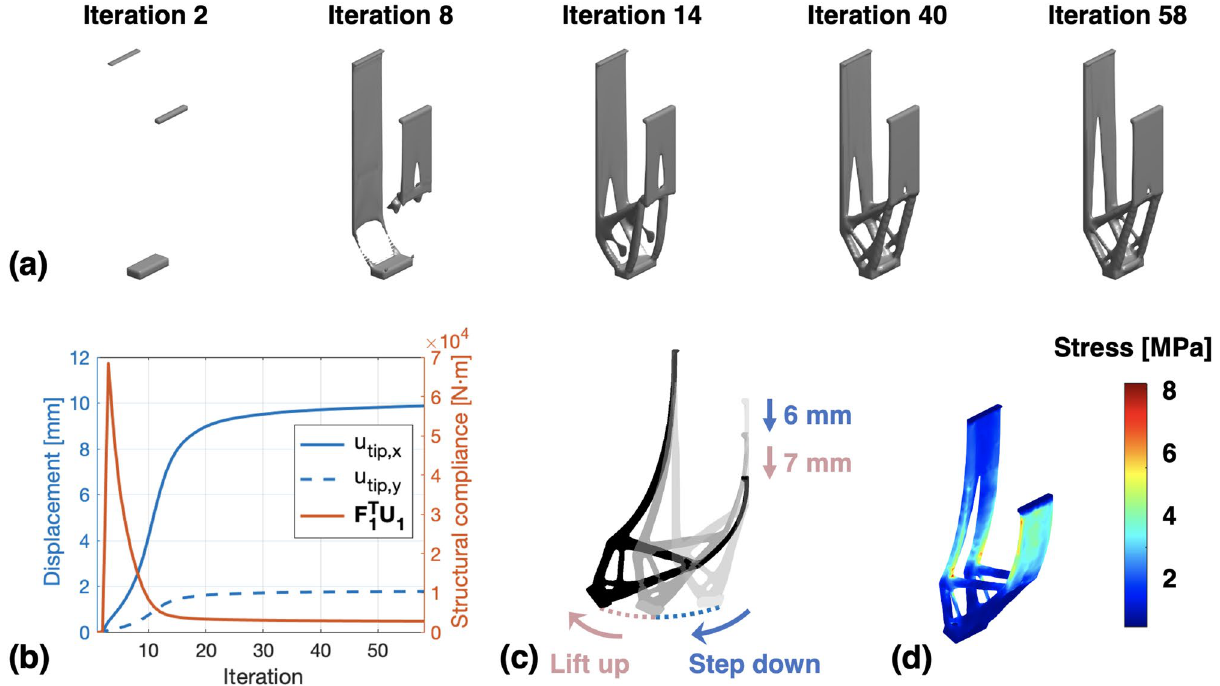
Figure 3. The optimization process and the realized compliant leg in “Application to compliant leg design” section: ( a ) Evolutionary process of the compliant leg shape, ( b ) Trend of the multiple design objectives during the optimization process, ( c ) FEM-simulated bending motion of the optimized leg, ( d ) FEM-simulated stress distribution in the bent